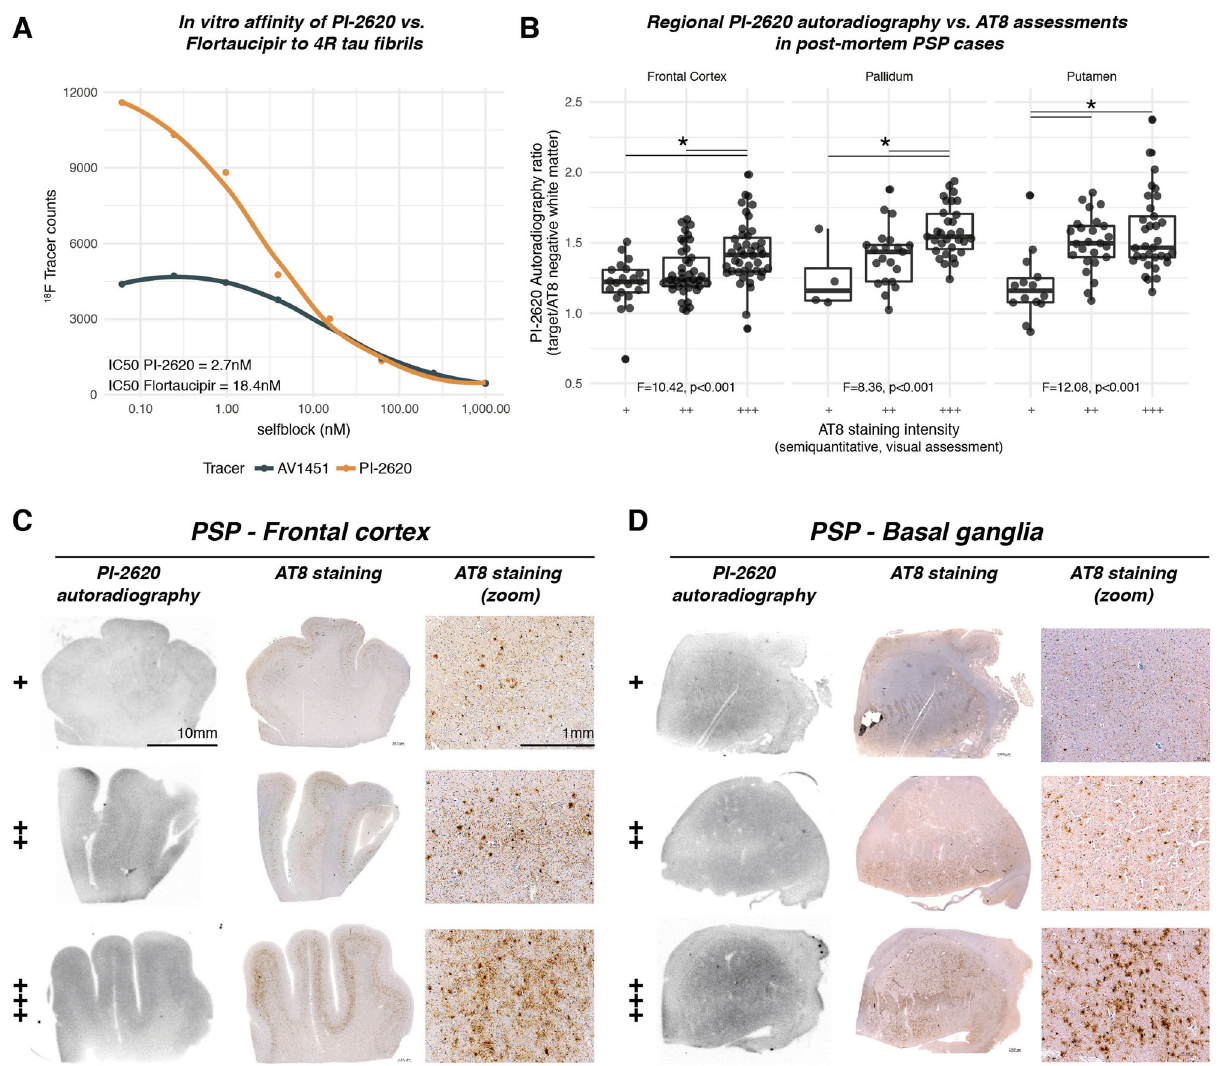
Fig. 2 Autoradiographic assessment of PI-2620 binding in PSP patients. In vitro competition assay, showing stronger af fi nity of PI-2620 to 4R tau fi brils than the fi rst generation tau-PET tracer Flortaucipir ( A ). In addition, we performed autoradiographic assessments in 233 brain samples derived from 16 patients with histopathologically con fi rmed PSP pathology. Samples were obtained from the frontal cortex ( n = 105), pallidum ( n = 56), and putamen ( n = 72). AT8 staining intensity was judged by visual expert read (low = + , medium = ++ , high = +++ ), autoradiography was quanti fi ed as the intensity of the autoradiographic signal in the target tissue divided by signal in AT8-negative white matter. Boxplot illustrating the comparisons between autoradiography signal and AT8 staining intensity are shown in B , examples of autoradiography samples and AT8 staining are shown for the frontal cortex in C , and the basal ganglia in D . Two-sided p -values have been determined via ANOVAs. Boxplots are displayed as median (center line) ± interquartile range (box boundaries) with whiskers including observations falling within the 1.5 interquartile range. Source data are provided as a Source Data fi